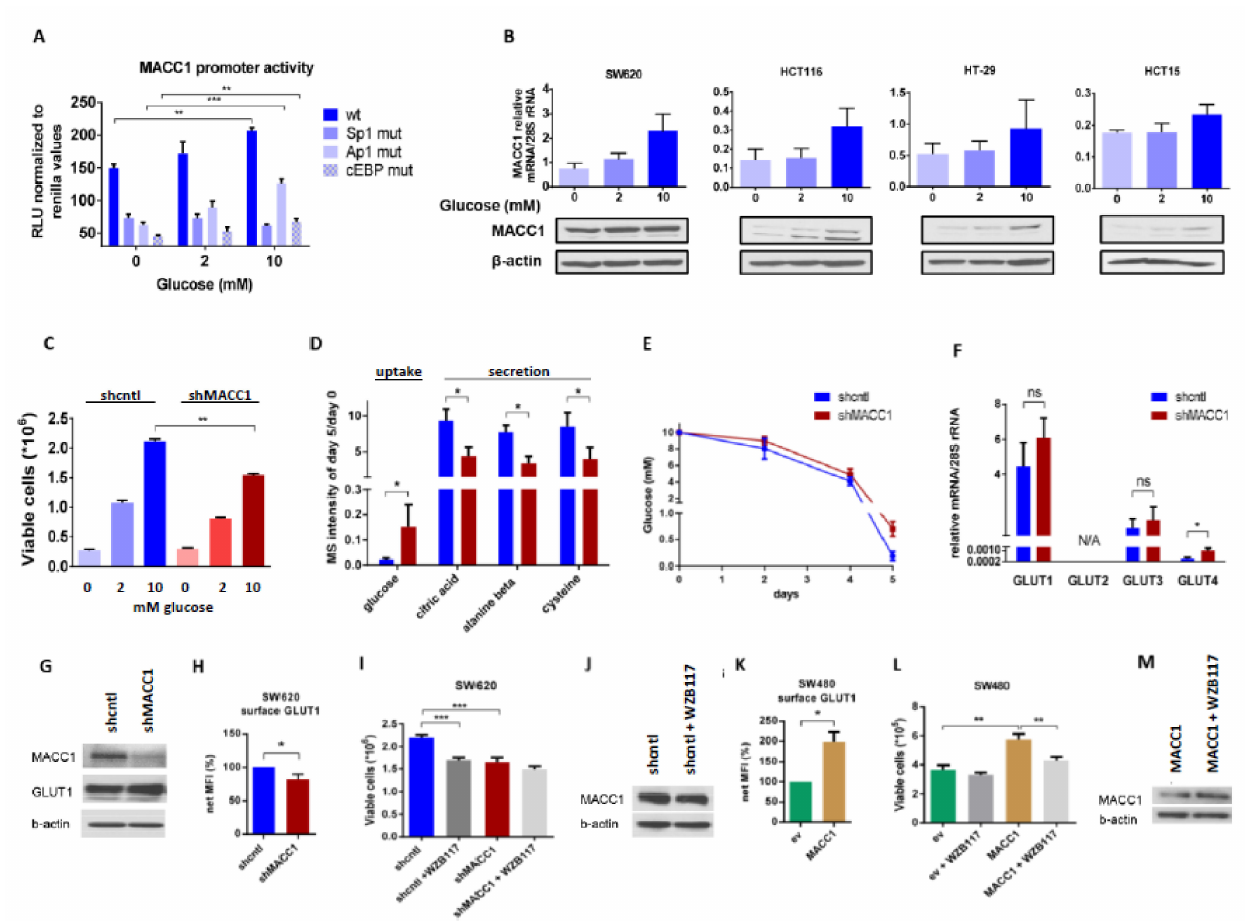
Figure 2. Surface GLUT1 is enhanced in MACC1 high cells. ( A ) MACC1 wt. promoter activity or activity with indicated mutated Sp1, Ap1, or cEBP binding sites was measured in HCT116 cells, treated with 0 mM, 2 mM and 10 mM glucose. ( B ) MACC1 mRNA and protein expression in SW620, HCT116, HT29 and HCT15 cells treated with 0 mM, 2 mM and 10 mM glucose. ( C ) Cell viability of SW620 shcntl and MACC1 shMACC1 (knockdown) cells treated with 0 mM, 2 mM and 10 mM of glucose. ( D , E ) GC-MS screening of growth medium metabolites after 5 days of culture of SW620 shcntl and SW620 shMACC1 cells grown in basal medium (supplemented with 10 mM glucose and 2 mM glutamine). ( D ) Levels of top differential metabolites, expressed relative to day 0 with fold-change > 2 and p < 0.05. ( E ) Gradual glucose depletion from ( D ) over period of 5 days. ( F ) GLUT1, GLUT2, GLUT3 and GLUT4 mRNA expression levels of SW620 shcntl and shMACC1 cells. ( G ) Total GLUT1 and, ( H ) GLUT1 surface protein expression in SW620 shcntl and shMACC1 cells. ( I ) Cell viability of WZB117 GLUT1 inhibitor treated SW620 shcntl and shMACC1 cells. ( J ) MACC1 expression of WZB117 treated SW620 shcntl cells. ( K ) GLUT1 surface expression in SW480/empty vector (ev) and SW480/MACC1 cells. ( L ) Cell viability of WZB117 treated SW480/ev and SW480/MACC1 cells. ( M ) MACC1 expression of WZB117 treated SW480/MACC1 cells. Data represent mean values ± SEM of at least three independent experiments; for GC-MS screening n = 3 technical replicates; * p ≤ 0.05, ** p ≤ 0.01, *** p ≤